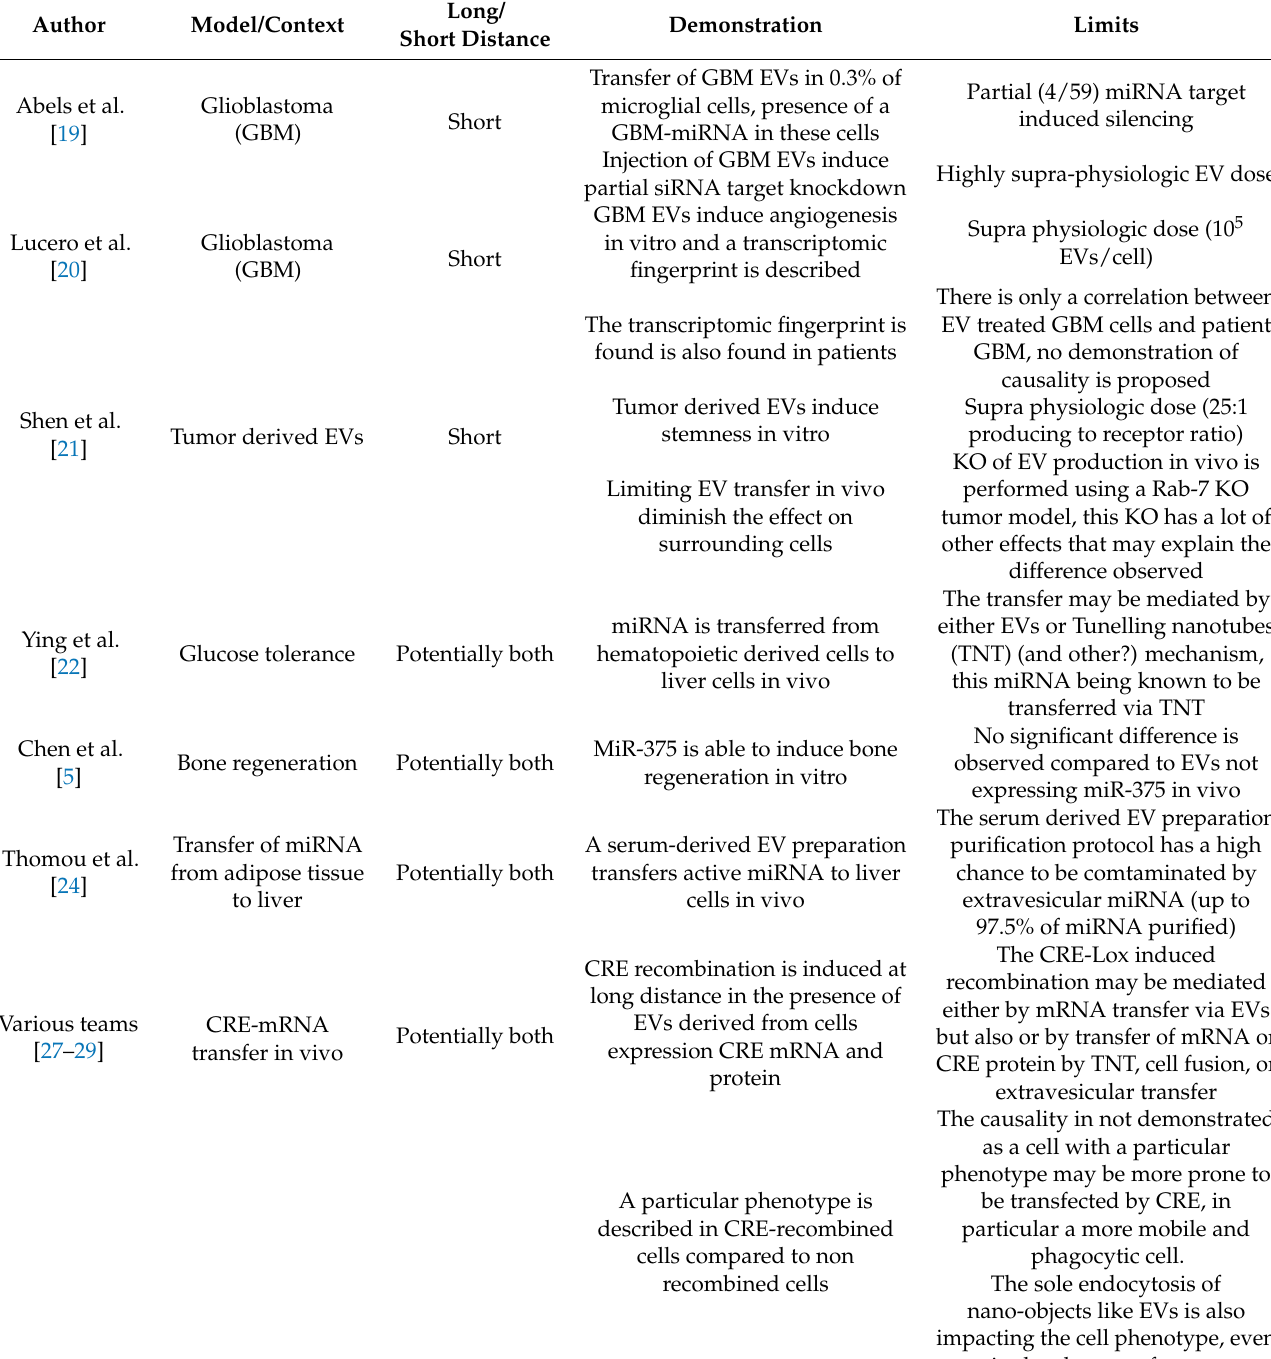
Table 1. Summary of articles describing the transfer of RNAs via EVs as a major mechanism of EV mediated